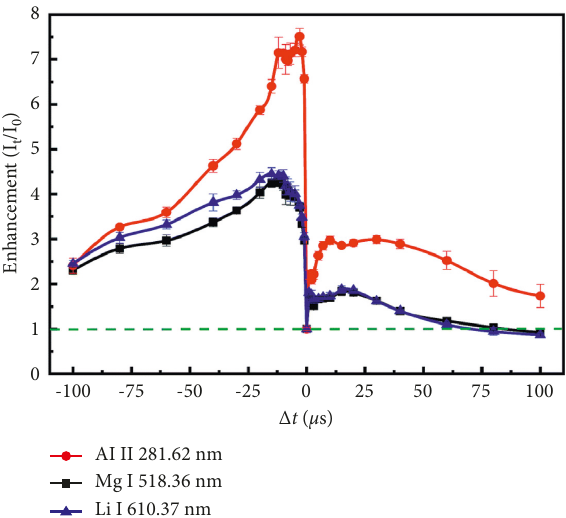
Figure 6: Signal enhancement for DP-LIBS as a function of interpulse separations, Δ t [95].